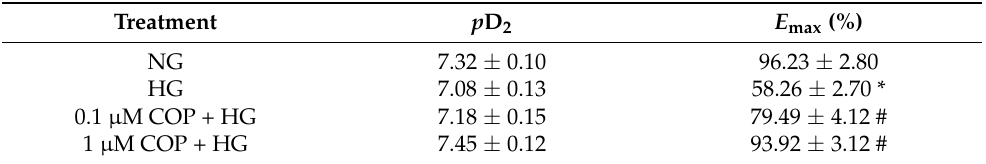
Table 1. p D 2 and E max (%) values for acetylcholine (ACh)-induced relaxations of mouse aortas exposed to high glucose (HG) and coptisine (COP) with mannitol as control (NG). Results are the